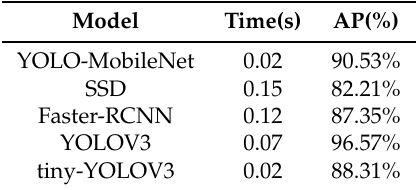
Table 2. Comparison with four popular object detection